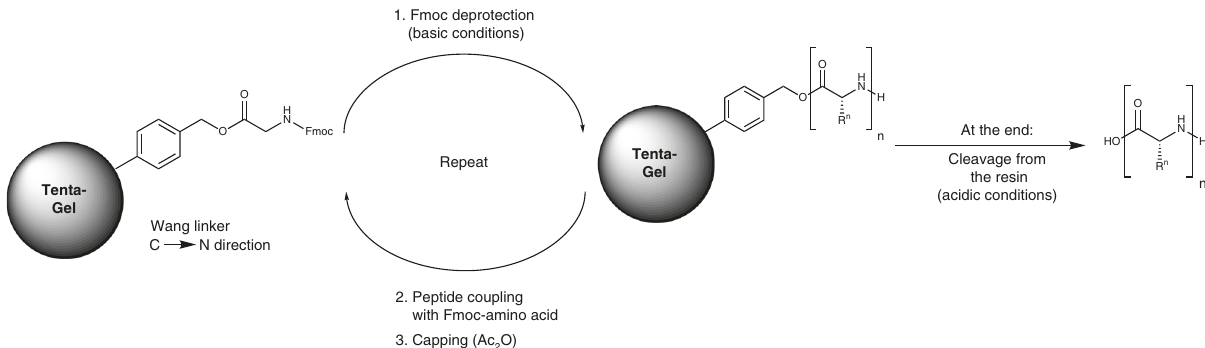
Fig. 5 Nanocode synthesis. SPPS protocol for the heteronuclear lanthanoid oligomers (Fmoc